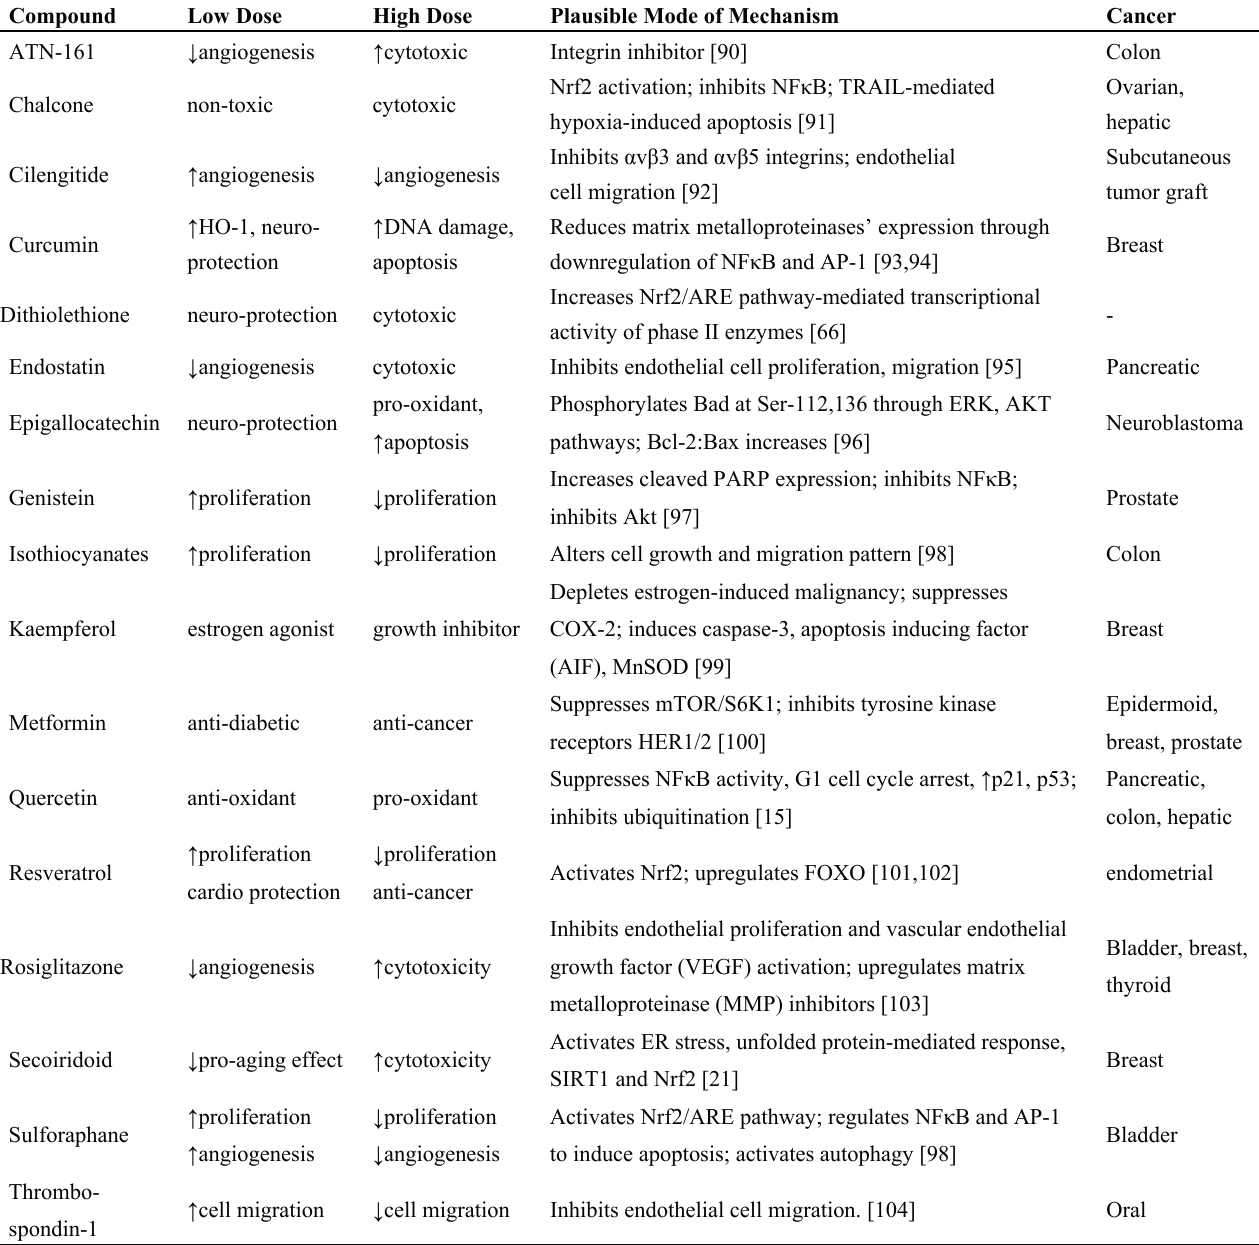
Table 1 . Hormetic compounds with cytotoxic activity towards cancer cells in vitro and in vivo